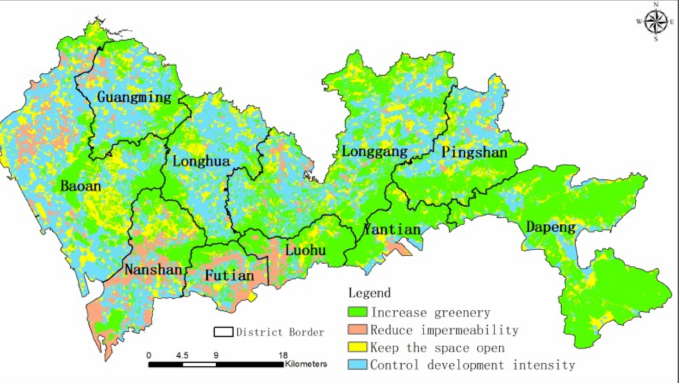
Figure 16. Urban climate analysis map of the thermal environment in